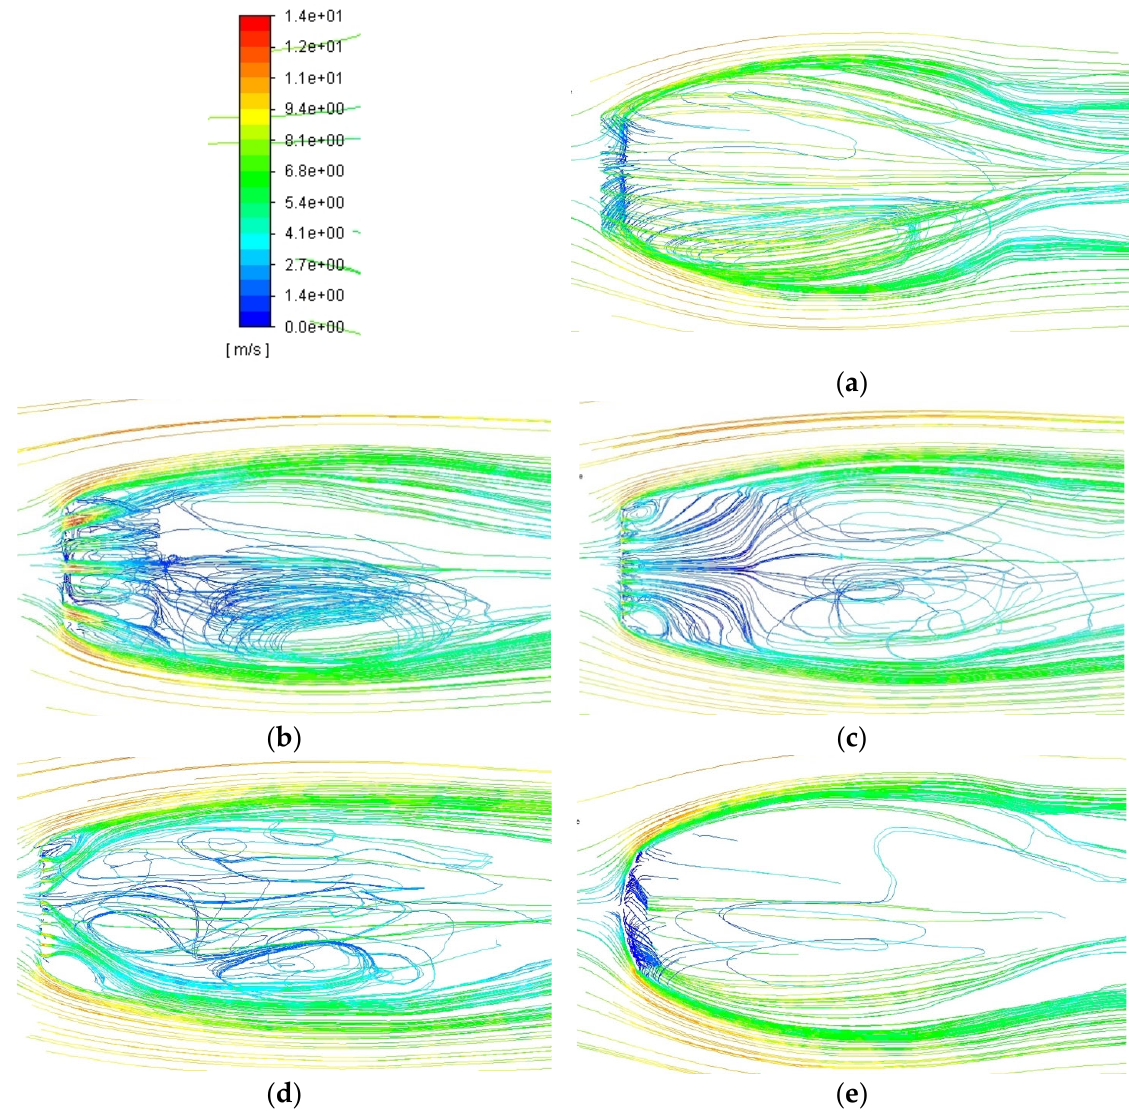
Figure 9. Path lines of airflow around: ( a ) standard panel, ( b ) 28 staggered holes, ( c ) 200 uniform square holes, ( d ) 10 rectangular slots, and ( e ) curved.